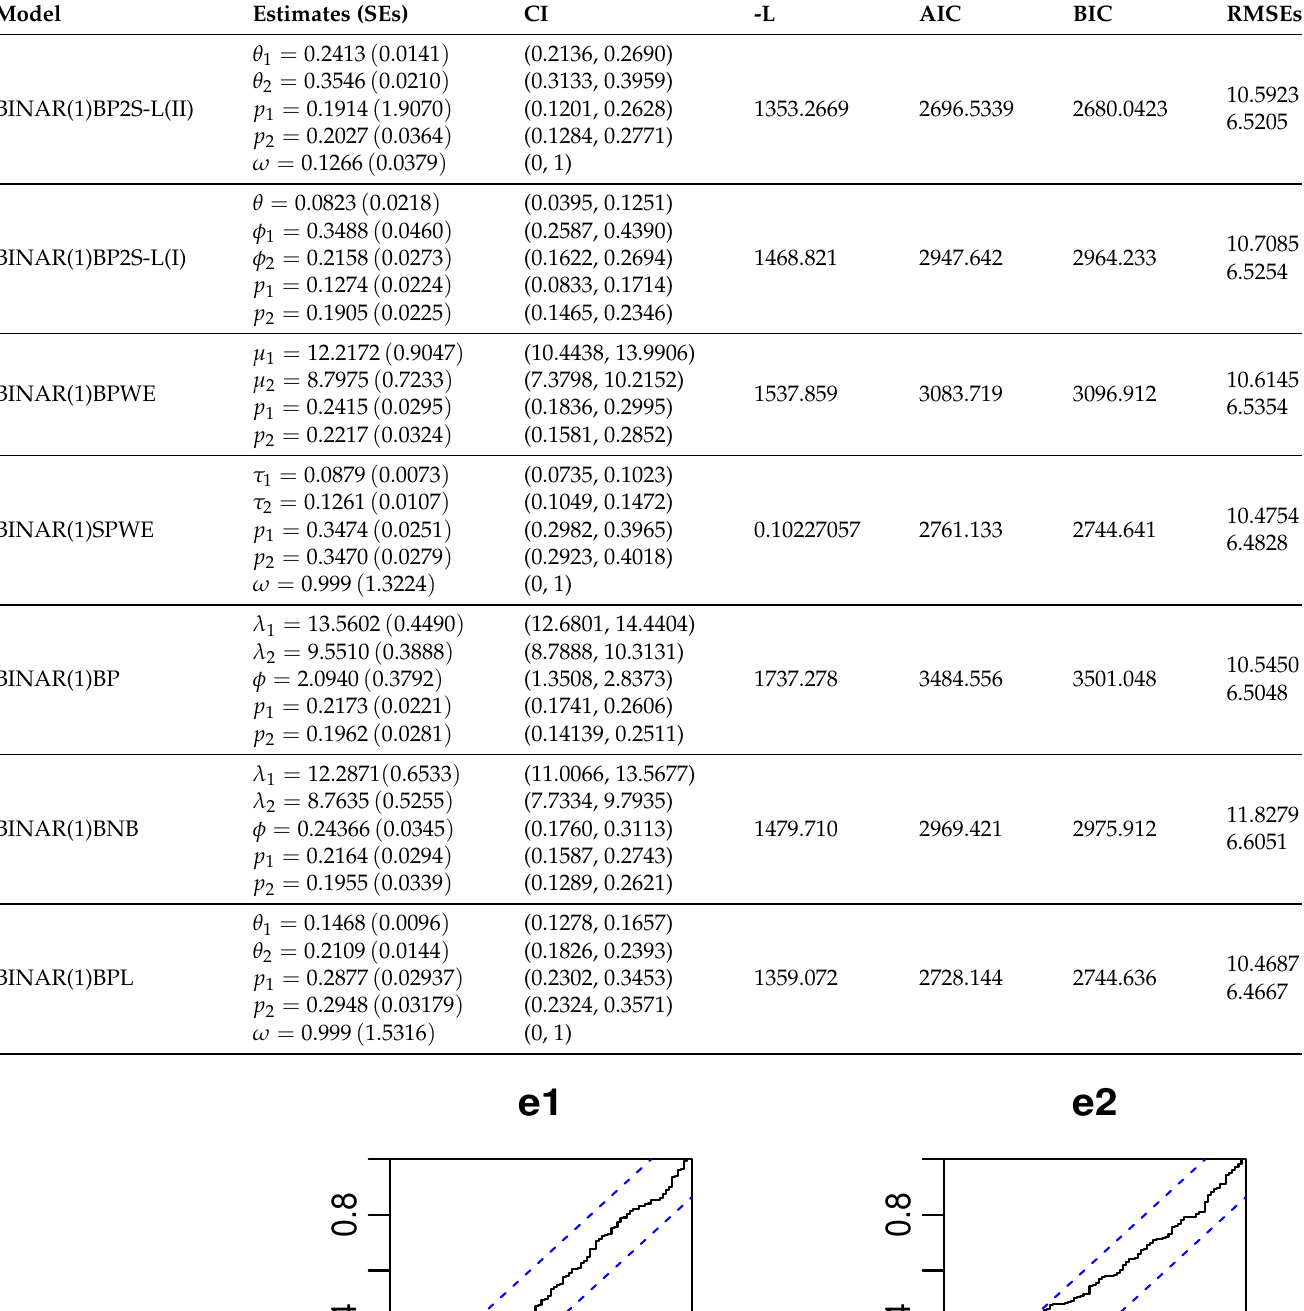
Table 8. Estimates with SEs and CIs, AIC, BIC, and RMSEs of the considered BINAR(1) processes for the sales of candies dataset.